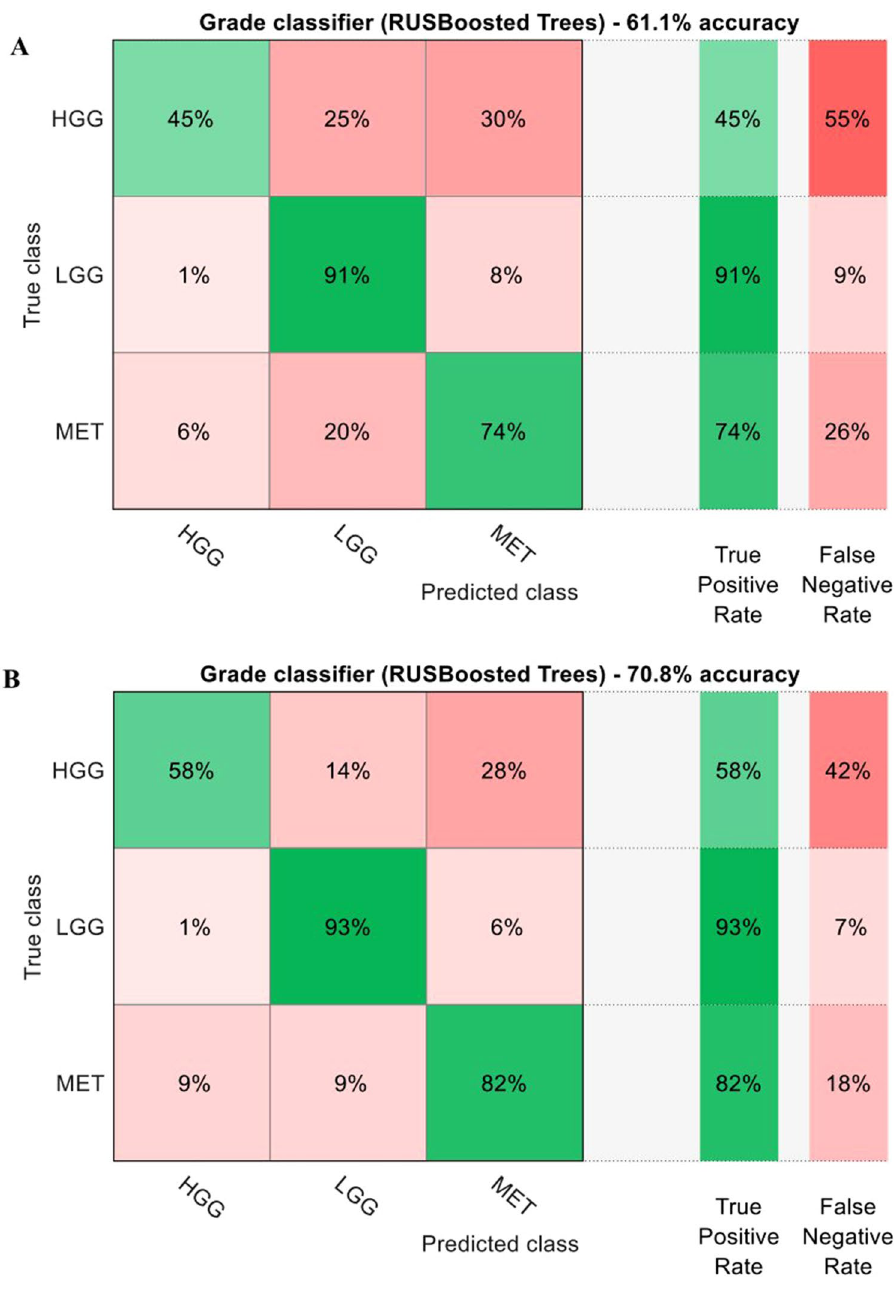
Figure 4. Classification of tumor entity/grade based on the fluorescence lifetime of PPIX only ( a ) and NADH/ PPIX combined ( b )—From each sample 100 fluorescence lifetime values were randomly chosen which resulted in overall 4200 datapoints. These were then classified using a RUS boosted trees classifier depending on the tumor grade. Solely relying on the PPIX fluorescence lifetime, the classifier reaches an accuracy of 61%. When adding the information of the colocalized NADH fluorescence lifetime, the accuracy reaches nearly 71%. This is mainly due to the better discrimination between brain metastases (MET) and high grade gliomas (HGG). Note that we did not include non-pathological samples due to the small sample size (n =